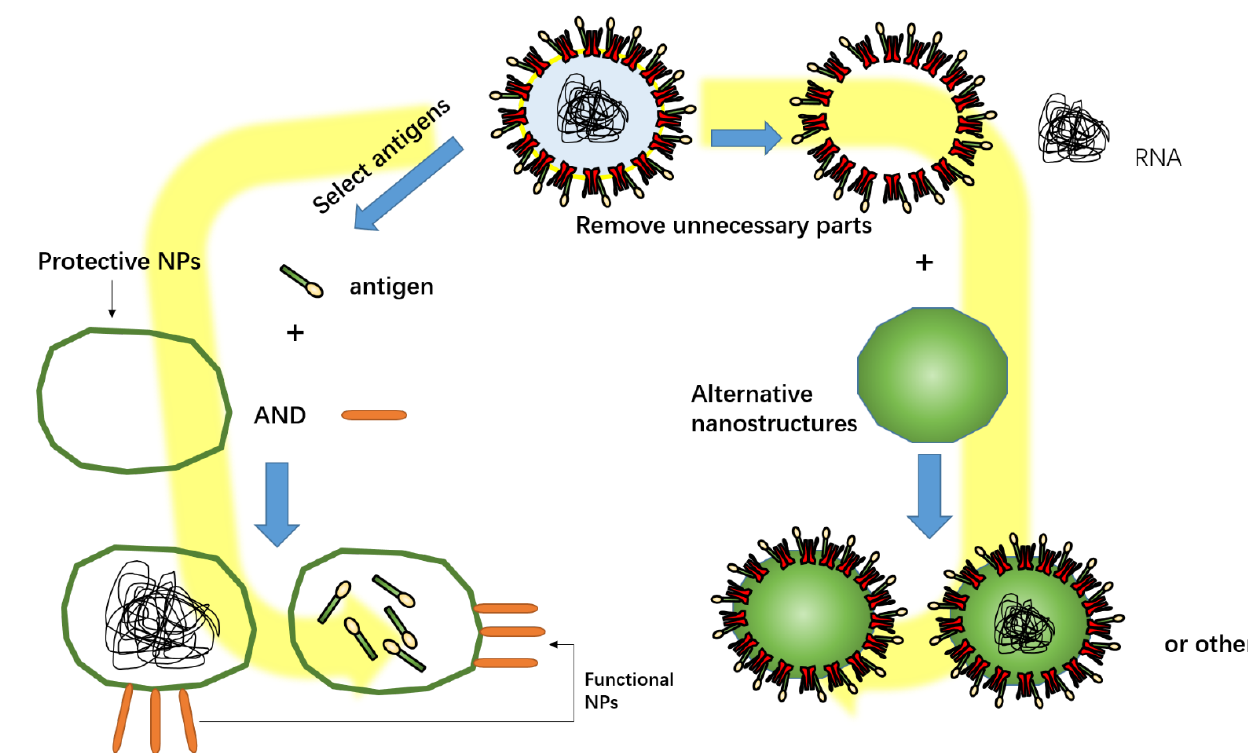
Figure 2. Functional NPs in SARS-CoV-2 vaccines mainly include promoting cell uptake of antigens, protecting antigens, and fully mimicking pathogens. Part of the structure of SARS-CoV-2 was selected to be wrapped in a nanocapsule, or superfluous structures removed from SARS-CoV-2 were replaced with NPs.